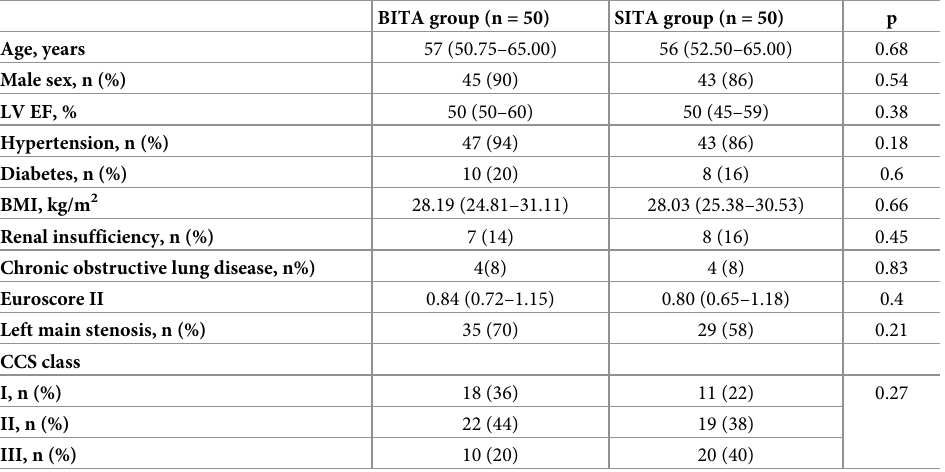
Table 1. Baseline patient